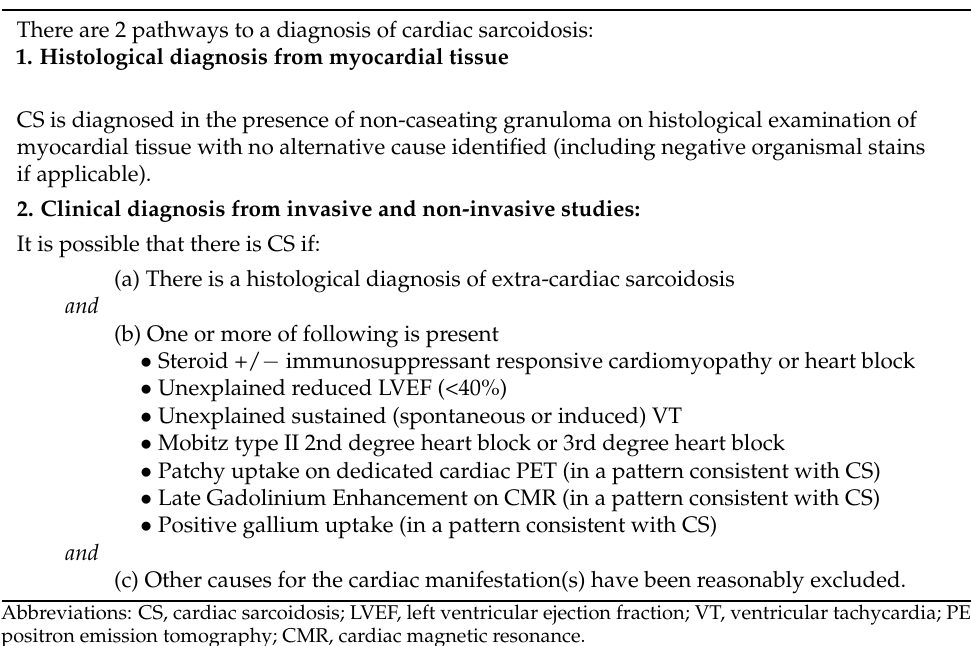
Table 2. The revised Japanese Ministry of Health and Welfare criteria for the diagnosis of cardiac